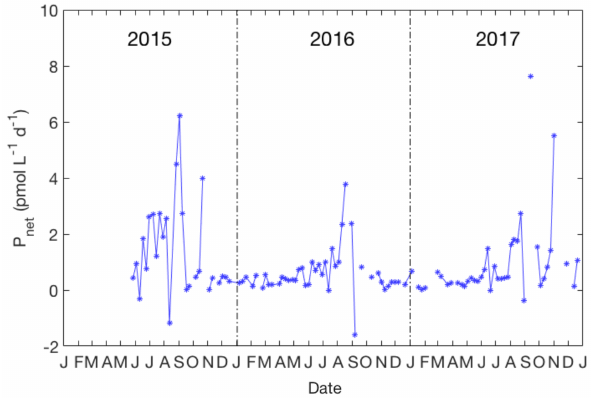
Table 4. Concentration (pmolL − 1 ) of iodocarbons measured at nearshore locations around Bedford Basin and at the regular sam- pling location on 19 July 2017 (1: Tufts Cove, 2: Wrights